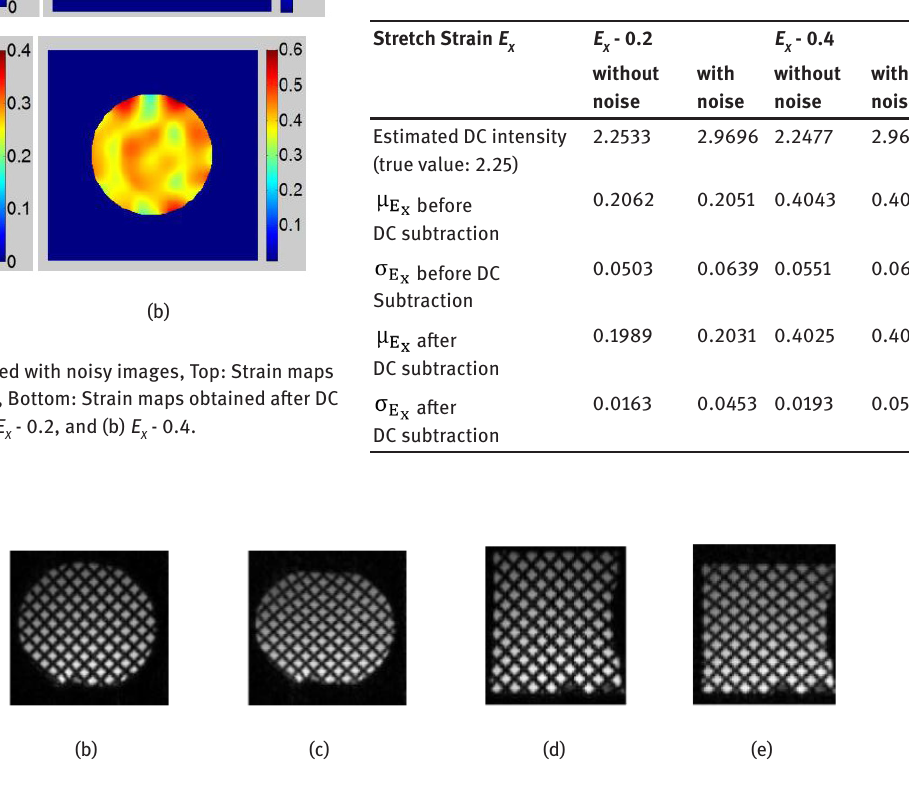
Figure 7: (a) T1-MR image of agar gel phantom, (b)-(c) The first and ninth frame of axial tagged images and (d)-(e) The first and ninth frame of sagittal tagged images.